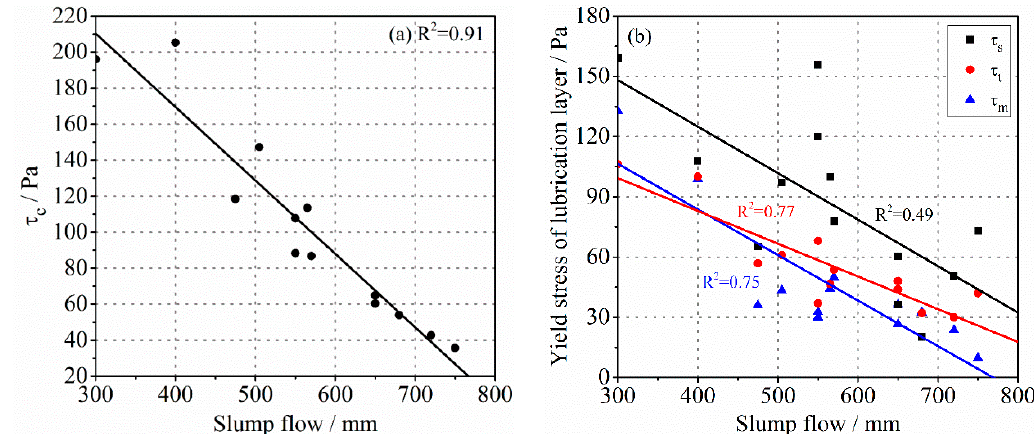
Figure 7. The relationship between the slump flow of concrete and the yield stress of ( a ) bulk concrete or ( b ) the lubrication layer.